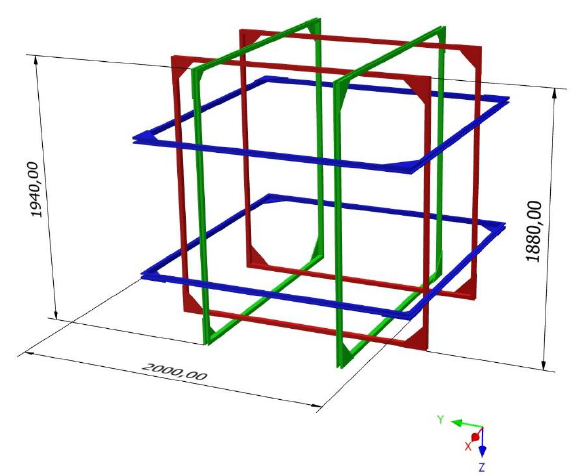
Figure 2. CAD model of the designed compensation system, based on square Helmholtz coils; dimensions in millimeters. Figure created using Inventor ® CAD software (Autodesk, Inc., San Rafael, CA, USA [53]). Sensors 2020 , 20 , x FOR PEER REVIEW